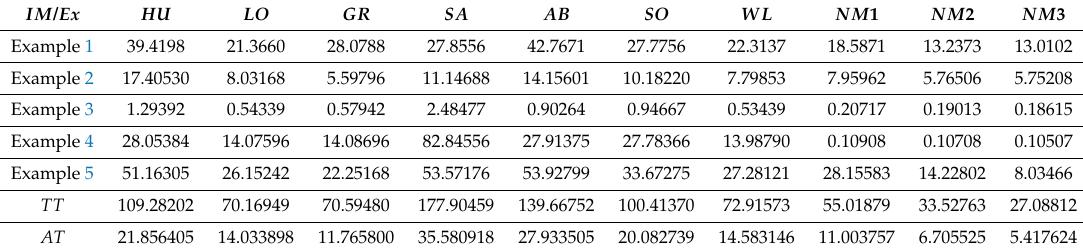
Table 9. Consumption of CPU time by distinct